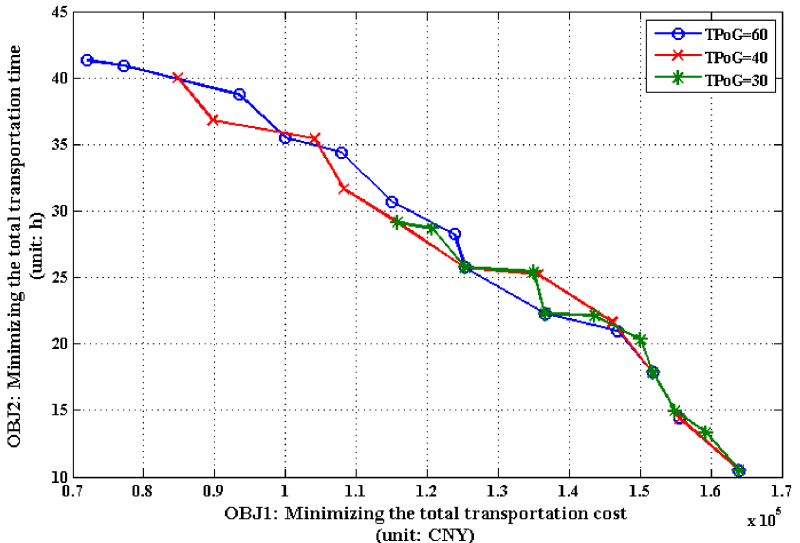
Figure 7. Sensitivity analysis of the transit period of goods on the Pareto